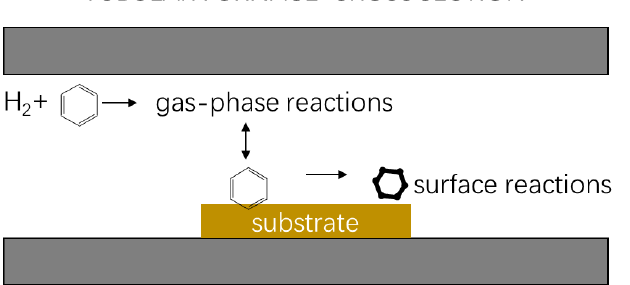
Figure 2. Mechanism of graphene growth from benzene at different temperatures (300~900 °C).